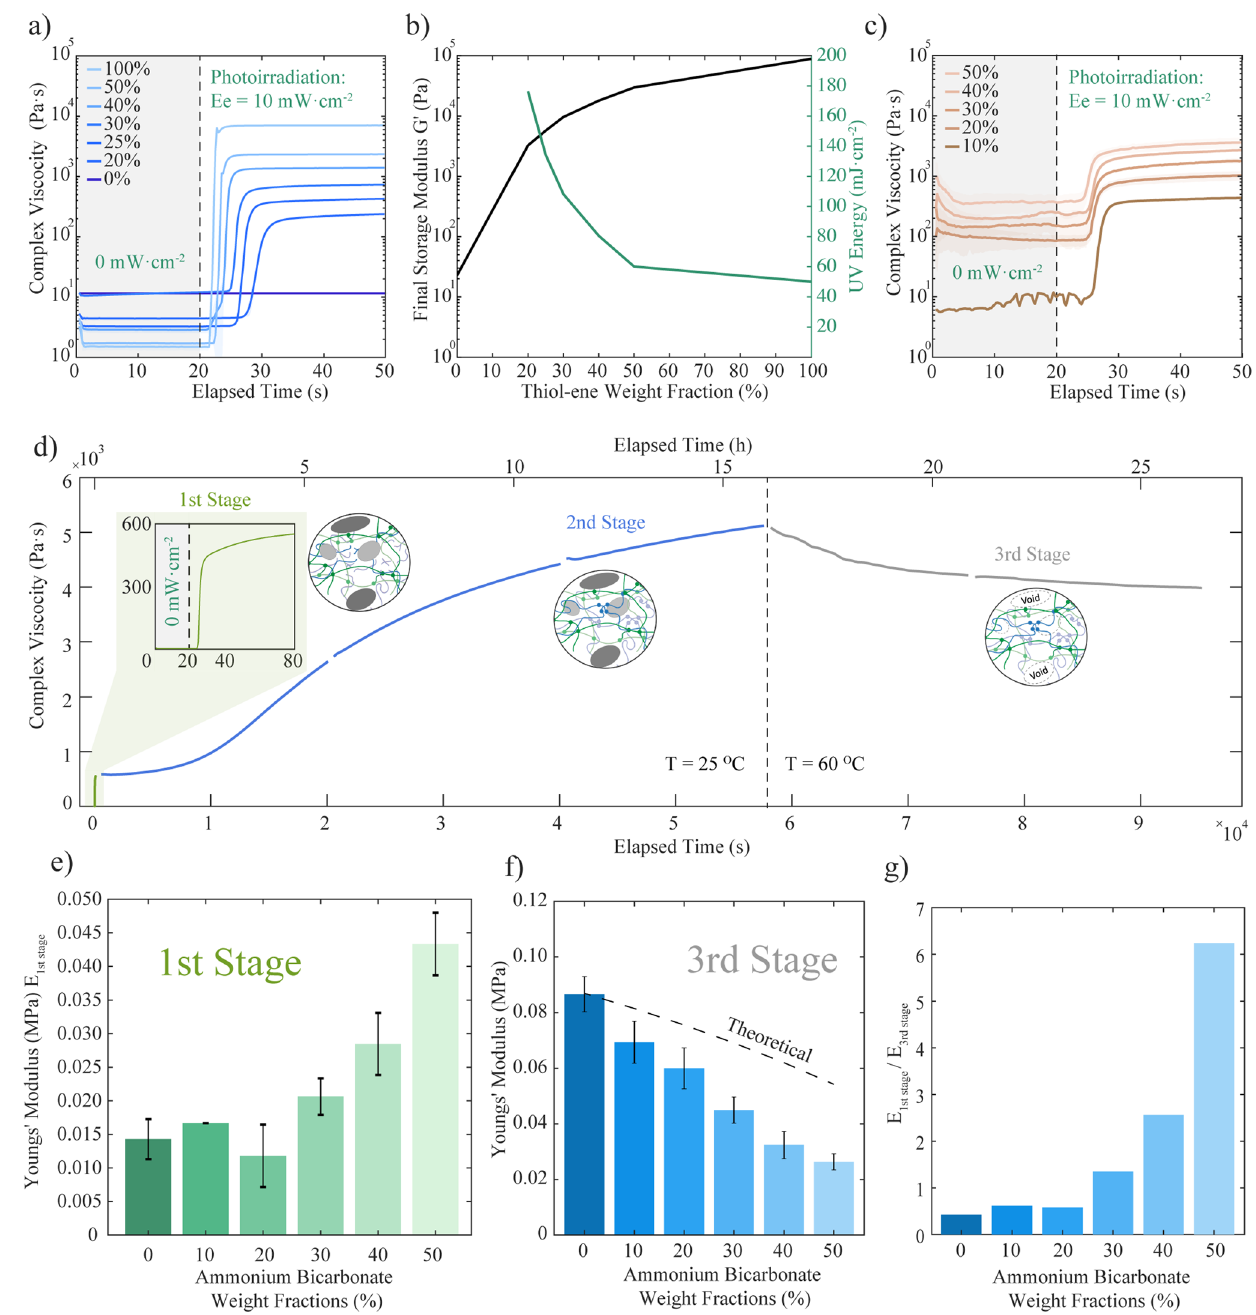
Fig. 2 Photorheology analysis of SilDNs for 3D DIW. a Effect of thiol-ene weight fraction on fi nal complex viscosity ( η ) over time. Rise points start immediately at 20 s with photoirradiation ( λ = 405 nm, E e = 10 mJ cm − 2 ) at the rheometer plate interface. Shaded regions represent one standard deviation. b Effect of thiol-ene weight fraction in print ink composition on fi nal storage modulus ( G ’ ). The second y -axis represent required UV energy (mJ·cm − 2 ) for print material to reach gelation point. c Effect of ammonium bicarbonate weight fraction on fi nal complex viscosity ( η ) over time. Rise points start immediately at 20 s with UV light penetration at the rheometer plate interface. Shaded regions represent one standard deviation. d Effect of each curing stage on complex viscosity ( η ) over time. 1st stage: thiol-ene crosslinking, 2nd stage: condensation crosslinking, 3rd stage: bicarbonate decomposition. e Young ’ s modulus values right after the completion of 1st stage during printing. f Young ’ s modulus values after full processing of the materials. Solid black line indicates expected Young ’ s modulus from weight fraction of porogen without volume expansion (See Supplementary Note 2 Equation 4, Supplementary Table 1). g Young ’ s modulus ratio of 1st stage over 3rd stage ( E 1st /E 3rd ) which highlights our system ’ s ability to improve print fi delity (1st stage modulus) while ultimately yielding a soft material (3rd stage modulus).